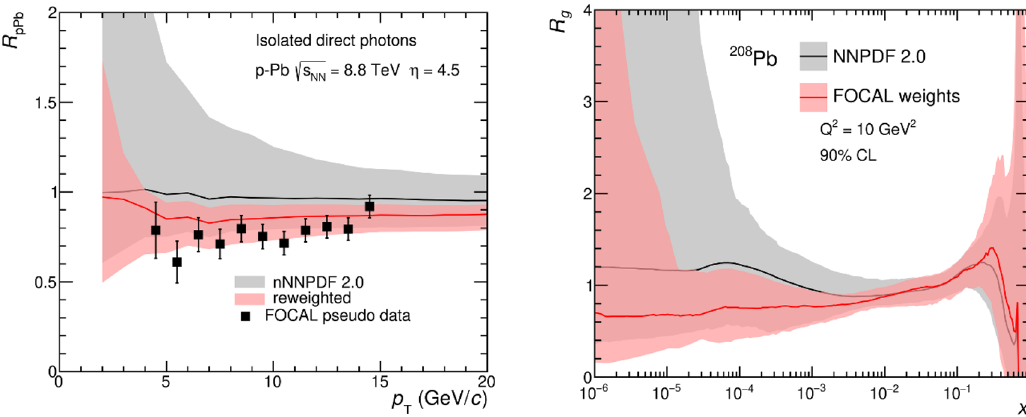
Figure 24 . Same as (cid:12)gure 23 now for the case where the FoCal pseudo data has been generated under the assumption that R pPb ’ 0 : 6 rather than based on the nNNPDF2.0 central